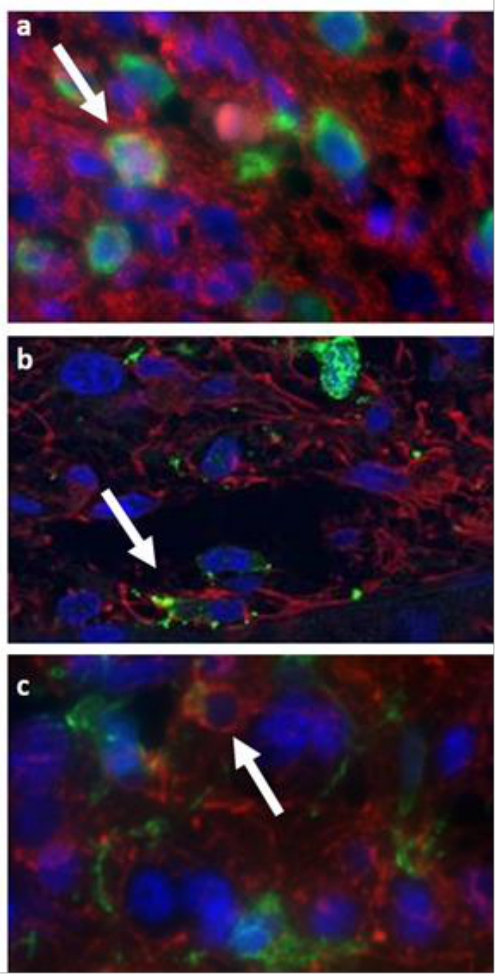
Figure 7. Immunofluorescence assays of GB01 tissue: ( a – c ) three different portions of GB01 tissue with GFAP (red) and IBA1 (green) markers shown. Arrows indicate cells with the double-positive signal.